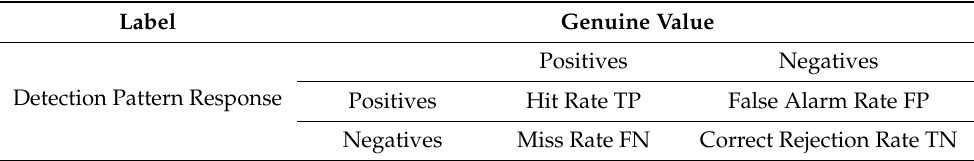
Table 3. Confusion matrix of the expressed detection pattern.